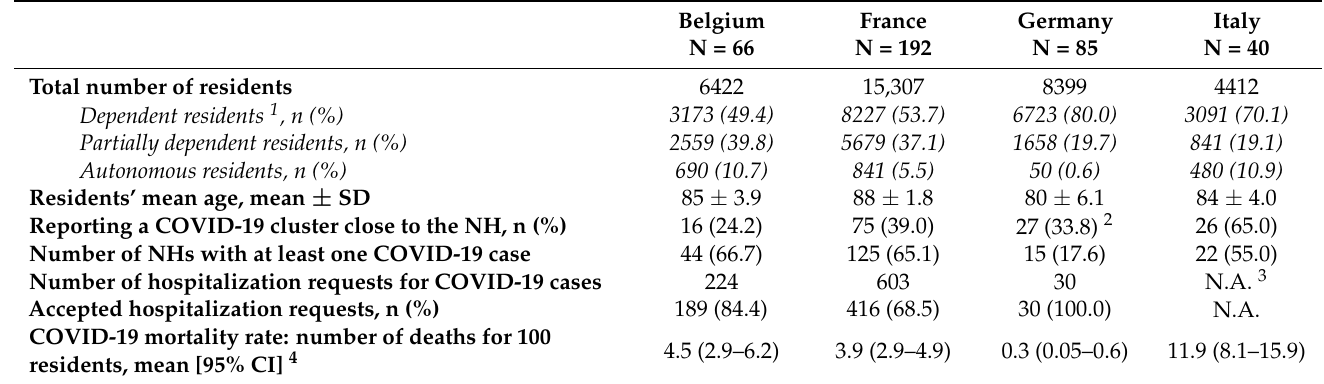
Table 1. Main characteristics of nursing homes (NHs) surveyed, mortality rates and hospitalization for COVID-19. CluDe Study,